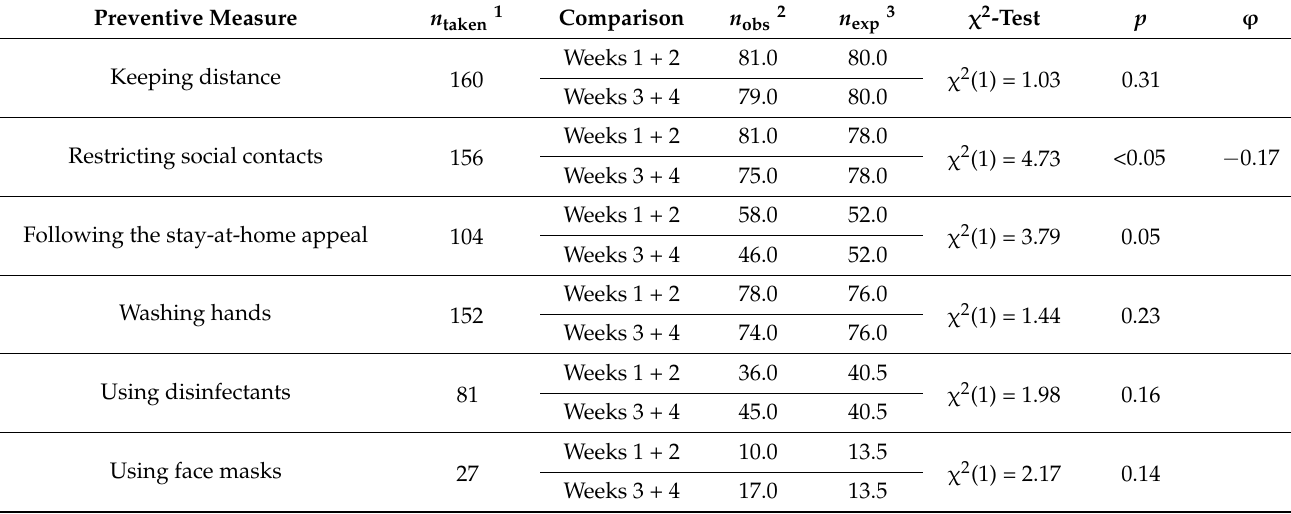
Table 2. Differences between the first and second half of the four-week investigation period with regard to preventive measures